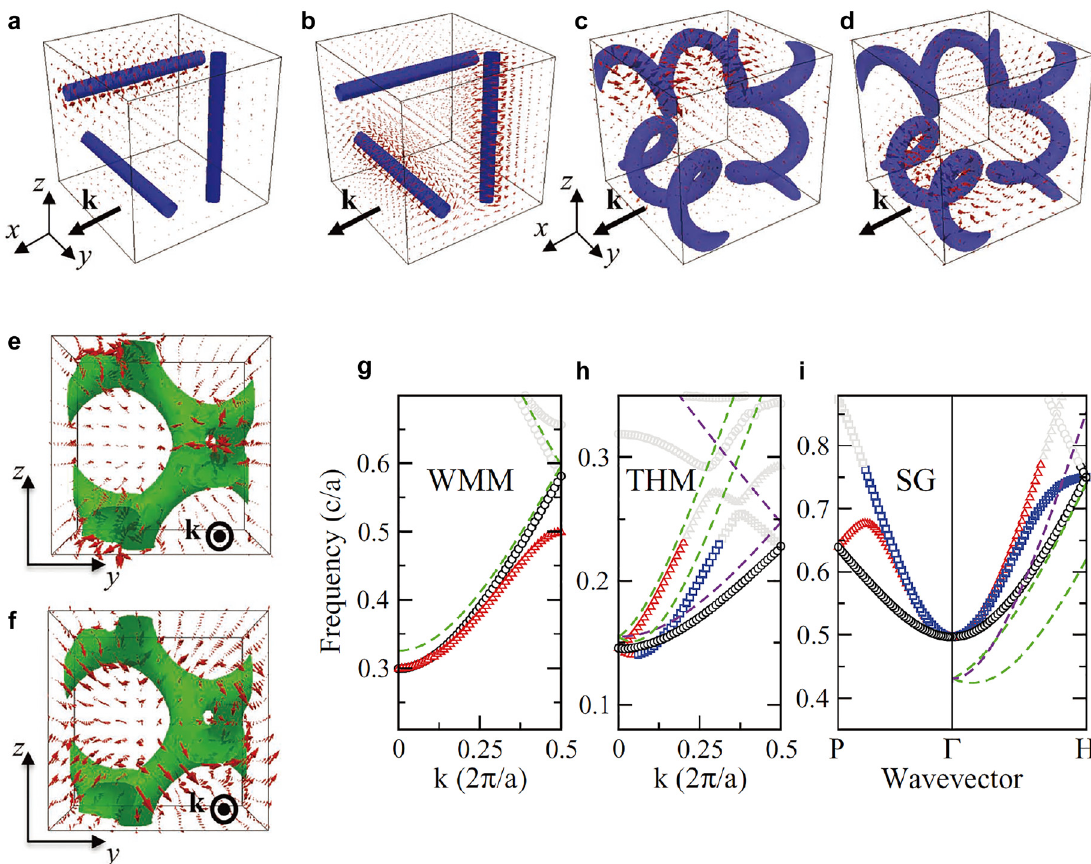
Figure 4: Wire mesh metamaterial (WMM), trihelical metamaterial (THM), and a single gyroid (SG) comprising perfect electric conductor. Electric field vectors for (a) longitudinal and (b) transverse modes in WMM, (c) longitudinal and (d) transverse modes in THM, and (e) longitudinal and (f) transverse modes in SG. (g), (h) and (i) Numerically calculated photonic bands (circles: longitudinal modes, squares, and triangles: transverse modes and analytical photonic bands (dashed lines) for WMM, THM and SG). Reproduced with permission from